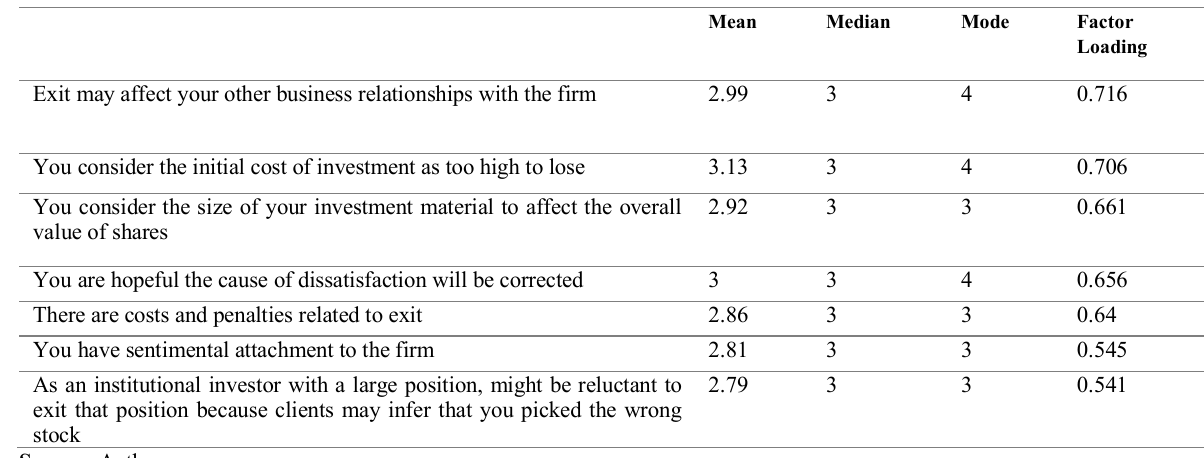
Table 2: Shareholder loyalty